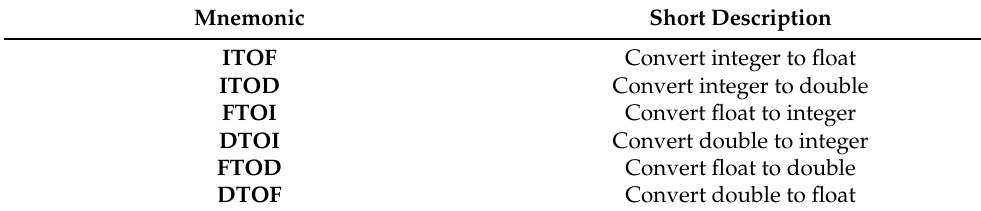
Table 3. Data conversion instruction subset.